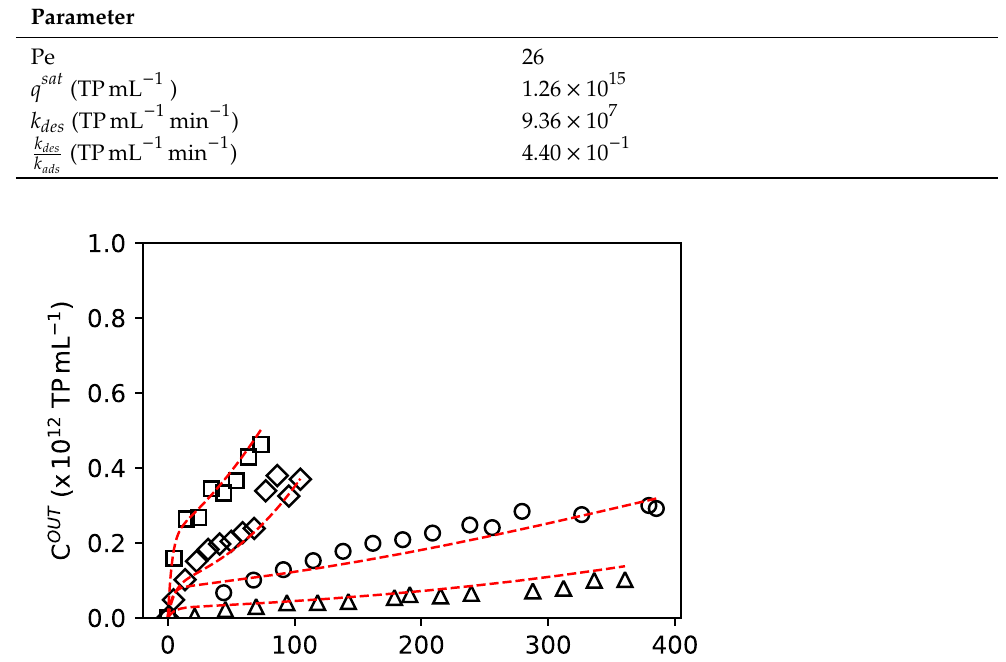
− 1 , △ : c FEED = 6.40 × 10 11 TPmL − 1 and Q FEED = 0.51 mLmin